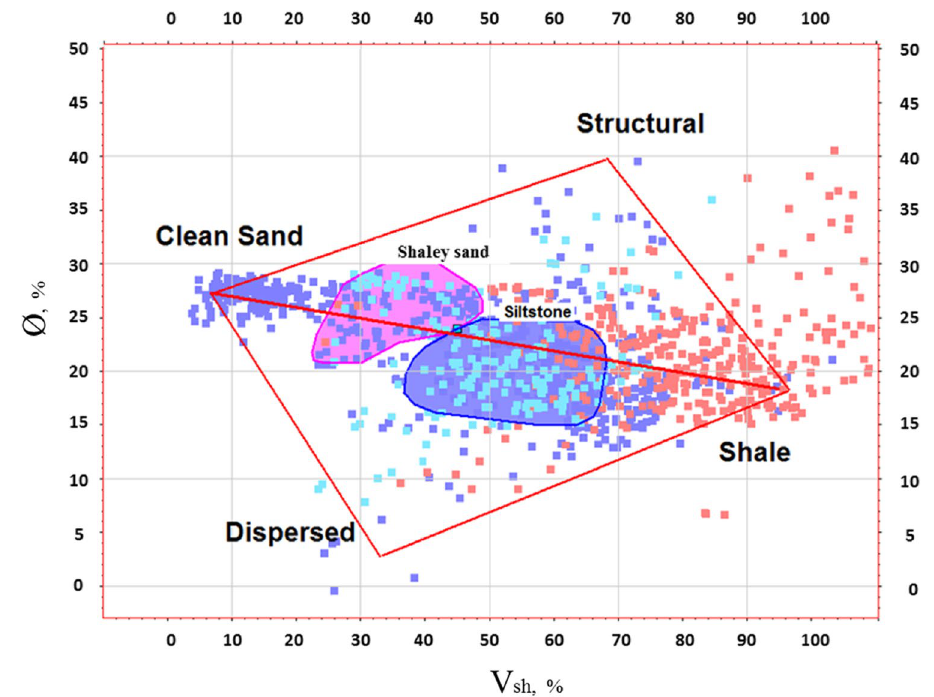
Fig. 5 Thomas Stieber plot showing the characteristics of Bahariya